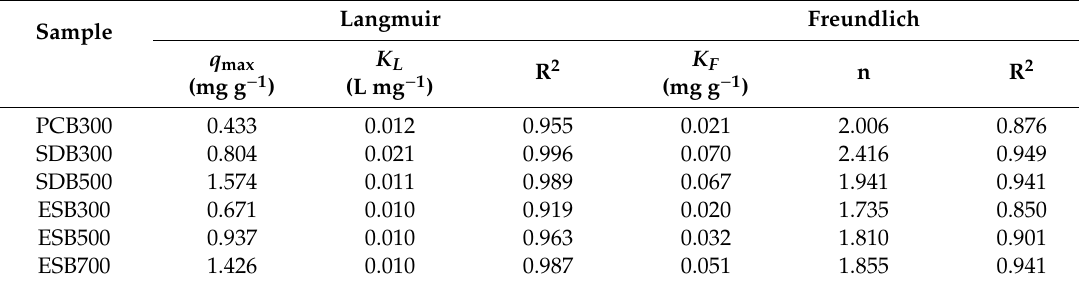
Table 5. Parameters of NO 3 − adsorption isotherms of di ff erent biochar. Langmuir Freundlich Sample